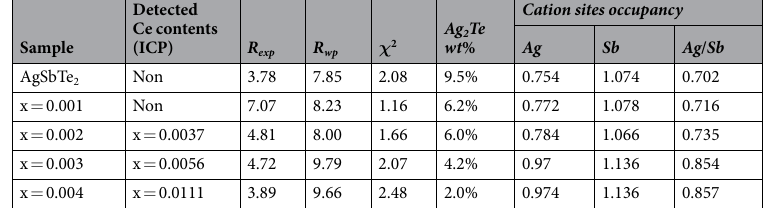
Table 1. Rietveld refinement results of the Ce-doped AgSb 1 − x Ce x Te 2